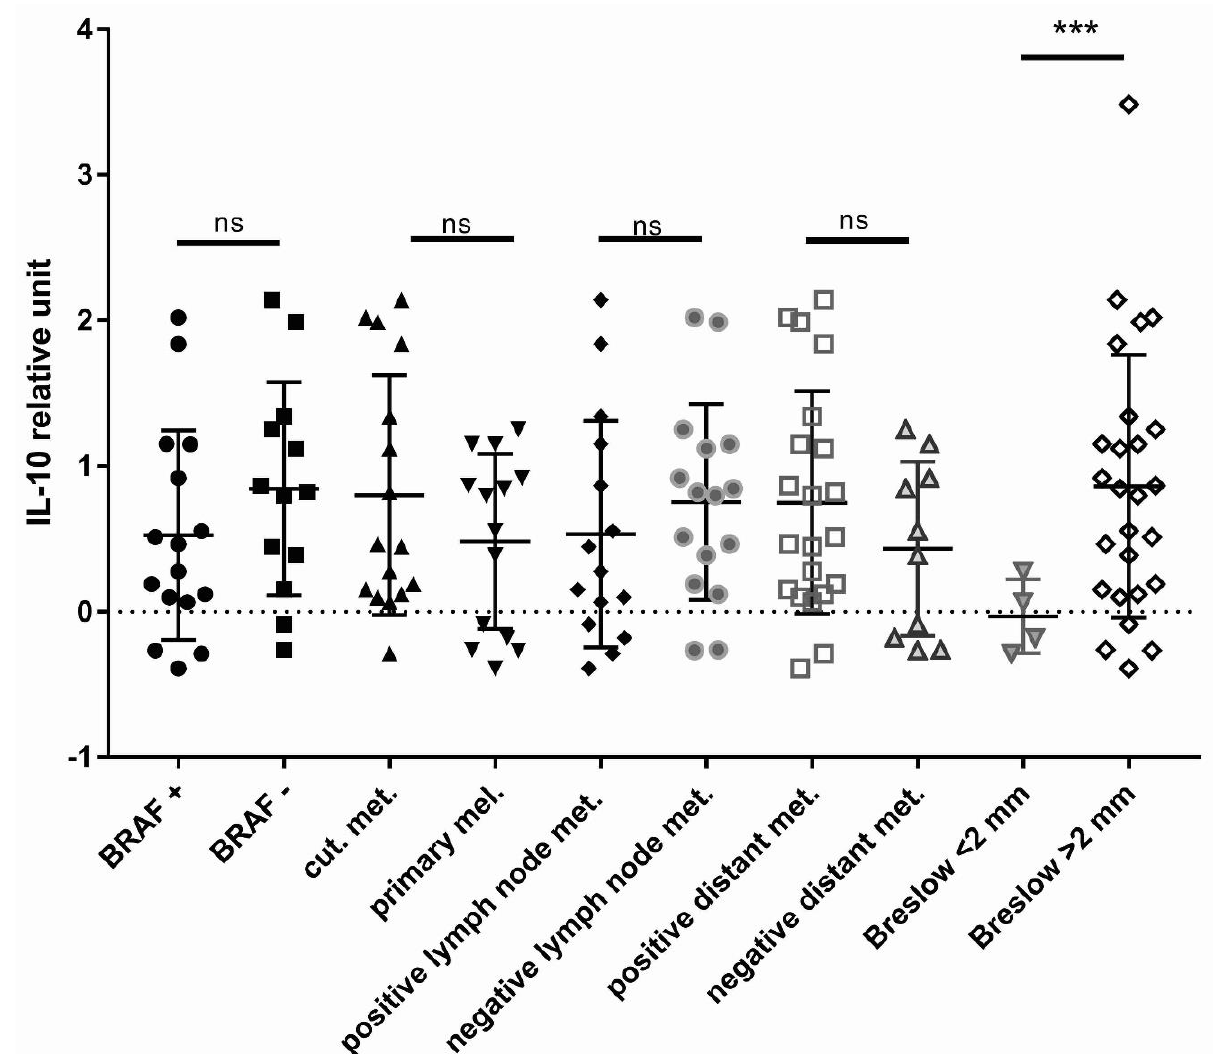
Figure 7. Clinical correlation of ex vivo IL-10 production of MAF macrophage co-cultures. Clinicopathological properties of melanomas and relative IL-10 concentration in supernatants of THP-1 macrophages co-cultured with MAFs isolated from tumors of various melanoma patients, n = 33 MAFs (isolated from 32 patients, MAFs from both primary tumor and metastasis of patient number 2 were isolated). ns: non-significant, *** p < 0.0005.